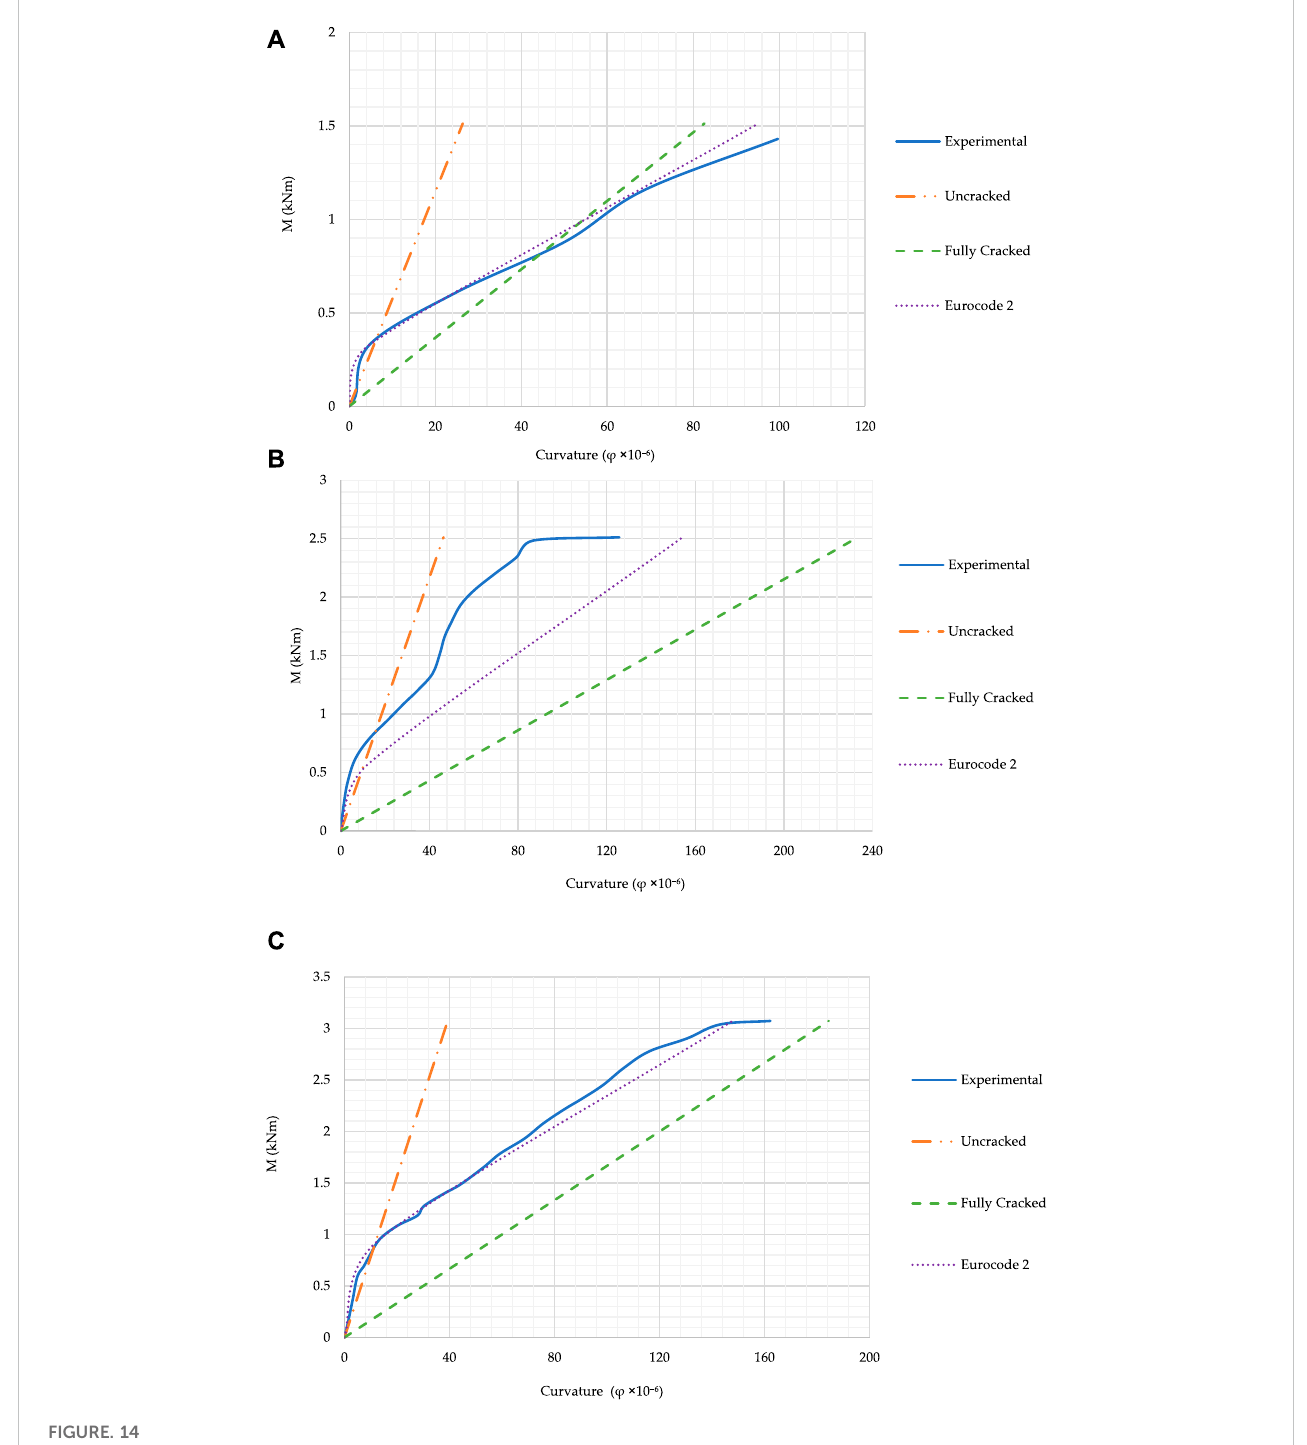
(cid:129) The textile reinforcing layer has shown to be effective, especially in terms of increasing cracking load. The load capacity of the textile reinforced slabs at the cracking, yield, and ultimate points was increased by 74%, 68%, and 66%, respectively, in SRC + 1T, and by 190%, 104%, and 103%, respectively, in SRC+2T.